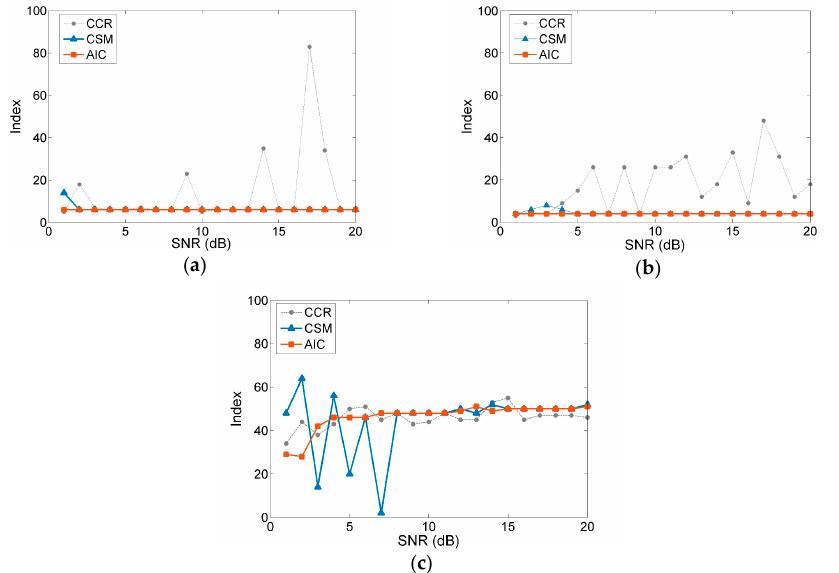
Figure 1. Comparison of the di ff erent methods in order determination: ( a ) signals s 1 ( SNRs ) ; ( b ) signals s 2 ( SNRs ) ; ( c ) signals s 3 ( SNRs ) . CCR: cumulative contribution rate; CSM: singular value curvature spectrum; AIC: Akaike information criterion; SNR: signal-to-noise